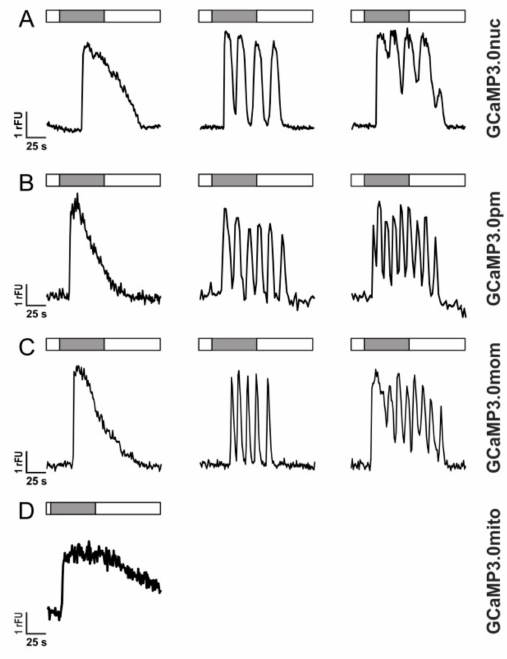
Figure 5. Histamine-induced Ca 2+ dynamics in HEK293 cells registered with GCaMP3.0 variants HEK293 cells were stably transfected with GCaMP3.0 variants: ( A ) GCaMP3.0nuc, ( B ) GCaMP3.0pm, ( C ) GCaMP3.0mom, and ( D ) GCaMP3.0mito. Cells were superfused with extracellular solution (ES: 120 mM NaCl, 5 mM KCl, 2 mM MgCl 2 , 2 mM CaCl 2 , 10 mM HEPES, 10 mM glucose, pH 7.4; white bar) or with ES containing 10 µ M histamine (gray bar). Ca 2+ -dependent fluorescence signals in individual cells were registered. Three types of signals were observed: (a) single transients (left row), oscillations (middle row), and oscillations on elevated basal fluorescence (right row). Except for GCaMP3.0mito ( D ) all other variants did not differ in detecting and tracing the cellular responses. The variants GCaMP3.0nuc, GCaMP3.0pm, and GCaMP3.0mom registered